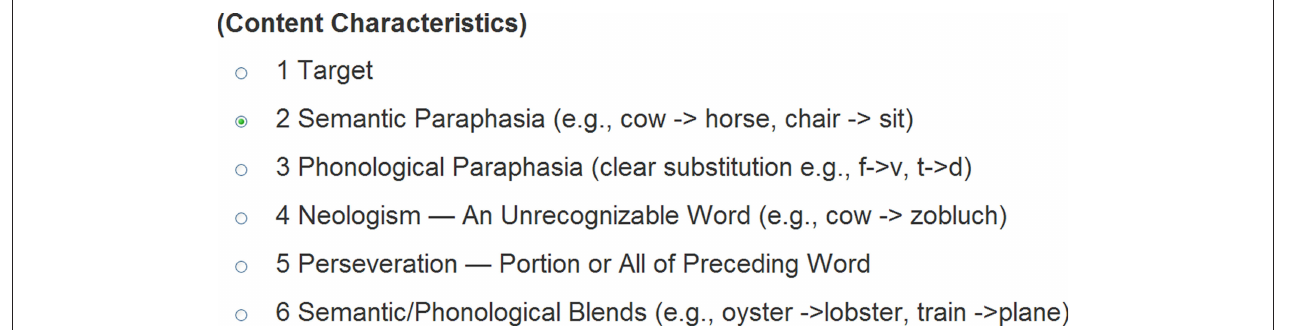
FIGURE 2 | Portion of DXBrain template query GUI